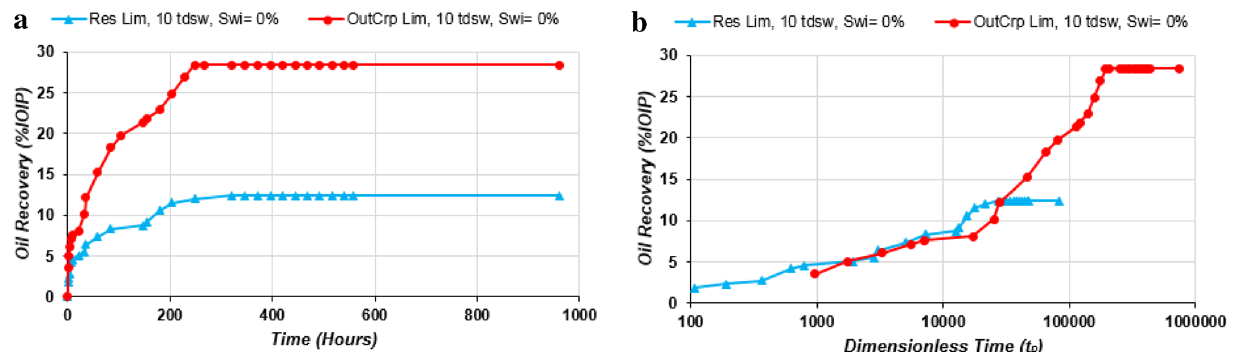
Fig. 5 Oil recovery (% IOIP) versus time resulted from spontaneous imbibition tests using outcrop carbonate cores (182 mD) and reser- voir carbonate ( k = 2.46 mD) in the absence of connate water satura-